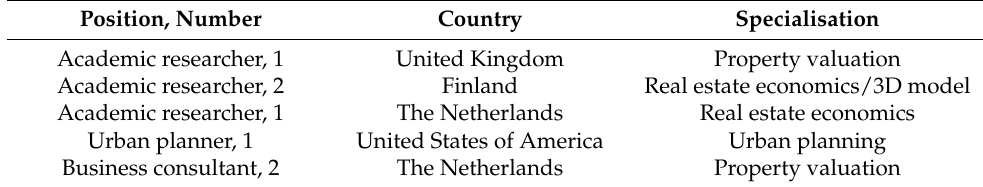
Table 2. The overview of the experts.